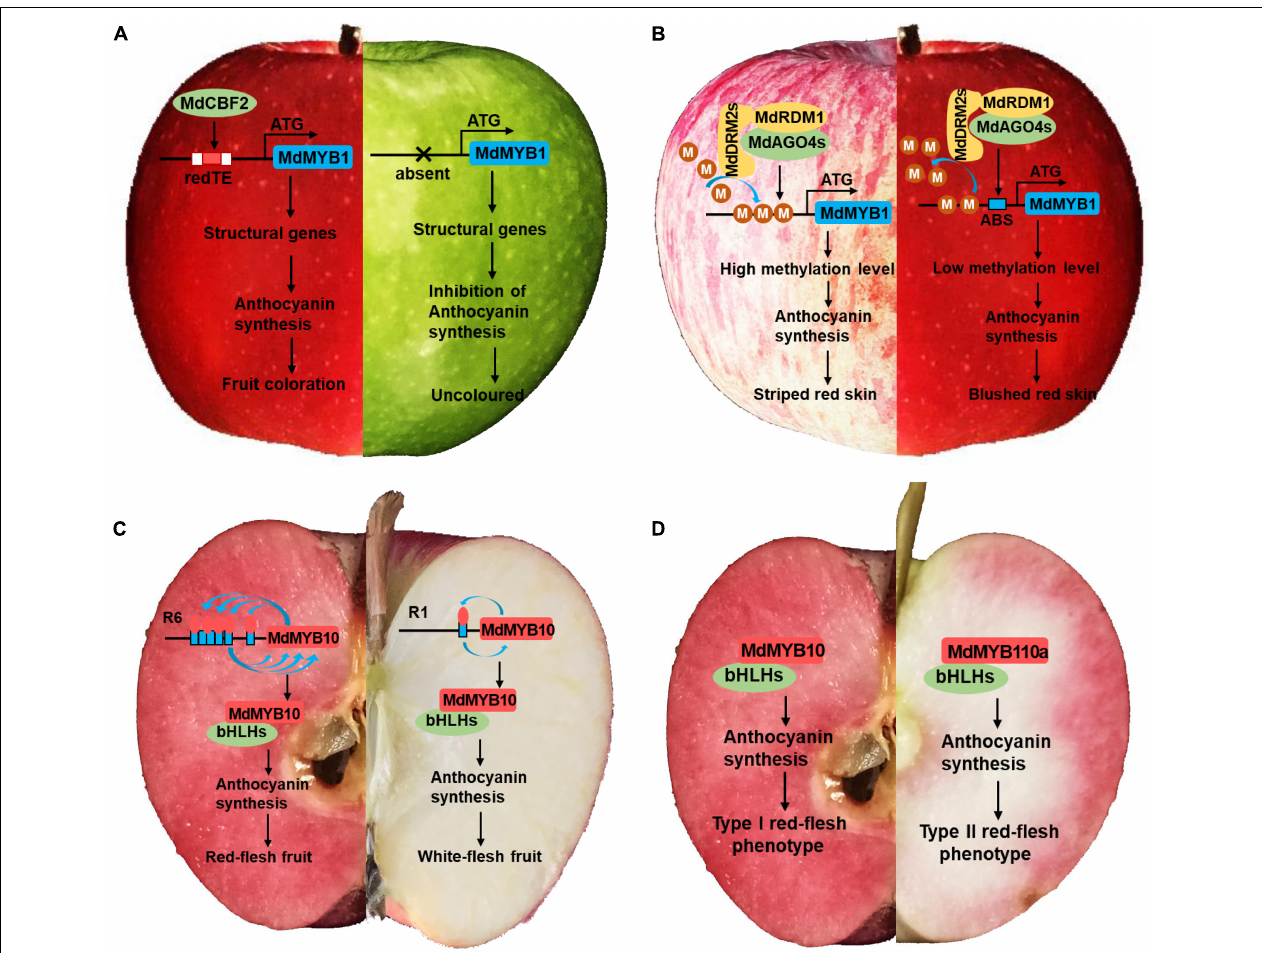
FIGURE 2 | Red pigmentation of apple fruit skin and flesh. (A) A gypsy-like long terminal repeat retrotransposon (designated redTE) was inserted 3297 bp upstream of MdMYB1 , thereby activating the expression of MdMYB1 and controlling the redness of the fruit skin. (B) MdAGO4s , MdDRM2s , and MdRDM1 interact with each other and form an effector complex. MdAGO4s recruit MdDRM2s , which catalyze CHH methylation of the MdMYB1 promoter. MdMYB1 then regulates anthocyanin accumulation to determine the coloration. M, a -CH 3 (methyl); ABS, AGO4 binding sequence. (C) Model showing autoregulation of the R6 and R1 promoters by MdMYB10 . The MdMYB10 promoter in red-fleshed apple contains six 23 bp repeating microsatellite sequences (R6), which confer MdMYB10 with self-activation. The MdMYB10 promoter in white-fleshed apple contains only one 23 bp repeating microsatellite sequence. (D) MdMYB10 and its homolog MdMYB110a are involved in the red pigmentation of type I and type II red-fleshed apples,